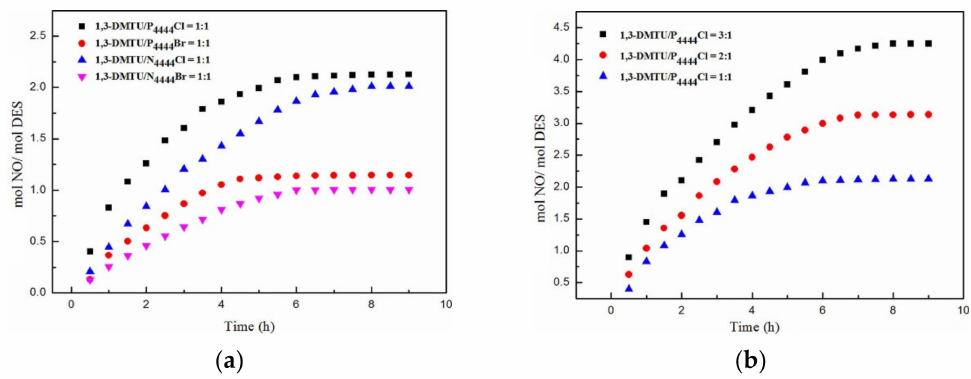
Figure 7. ( a ) NO absorption by DESs with different HBAs at 303.15 K; ( b ) NO absorption by DESs with different molar ratios of 1,3-DMTU to P 4444 Cl at 303.15 K (Reprinted with permission from Ref. [87]. Copyright (2017) American Chemical Society).